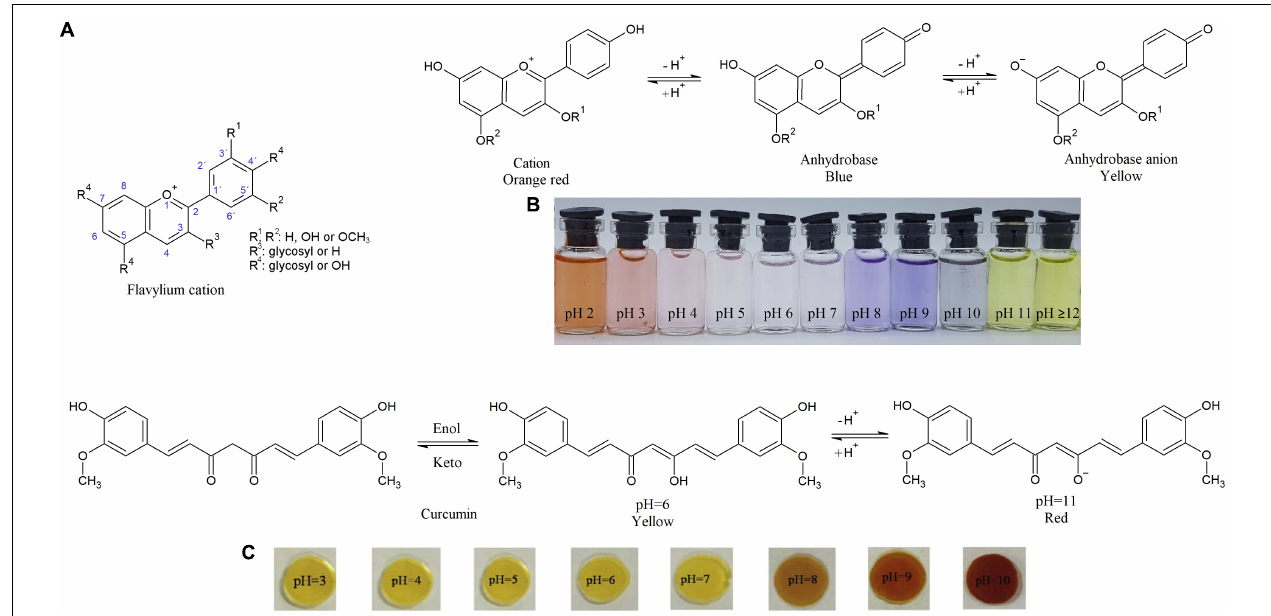
FIGURE 4 | (A) Flavylium cation. In naturally occurring anthocyanidins, the terminating chemical groups (–H, –OH, and –OCH 3 ) in the 3, 5, 6, 7 and the 3 (cid:48) , 4 (cid:48) , and 5 (cid:48) positions determine the original color of the molecule. pH-sensitivity and color change of (B) pelargonidin and (C) curcumin. [ (A) Reprinted from Phytochemistry 64(5), Kong et al. (2003). Copyright (2020) with permission from Elsevier. (B) Reprinted with permission from Zhai et al. (2018). Copyright (2020) American Chemical society. Reprinted from Spectrochim. Acta A 226, Chayavanich et al. (2020) Copyright (2020), with permission from Elsevier. (C) Reprinted from Food Hydrocolloid . 83, Liu et al. (2018) Copyright (2020), with permission from